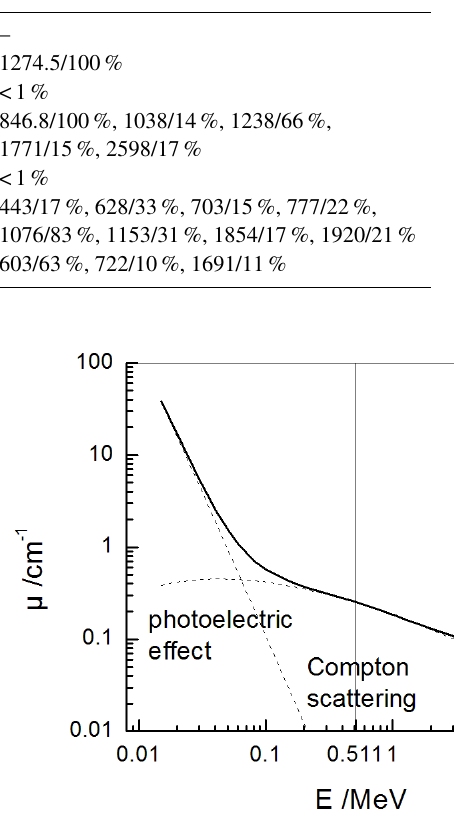
Table 1. Choice of PET nuclides (data from the National Nuclear Data Center, information extracted from the NuDat 2 database, http: //www.nndc.bnl.gov/nudat2/, 2016). Nuclide T 1 / 2